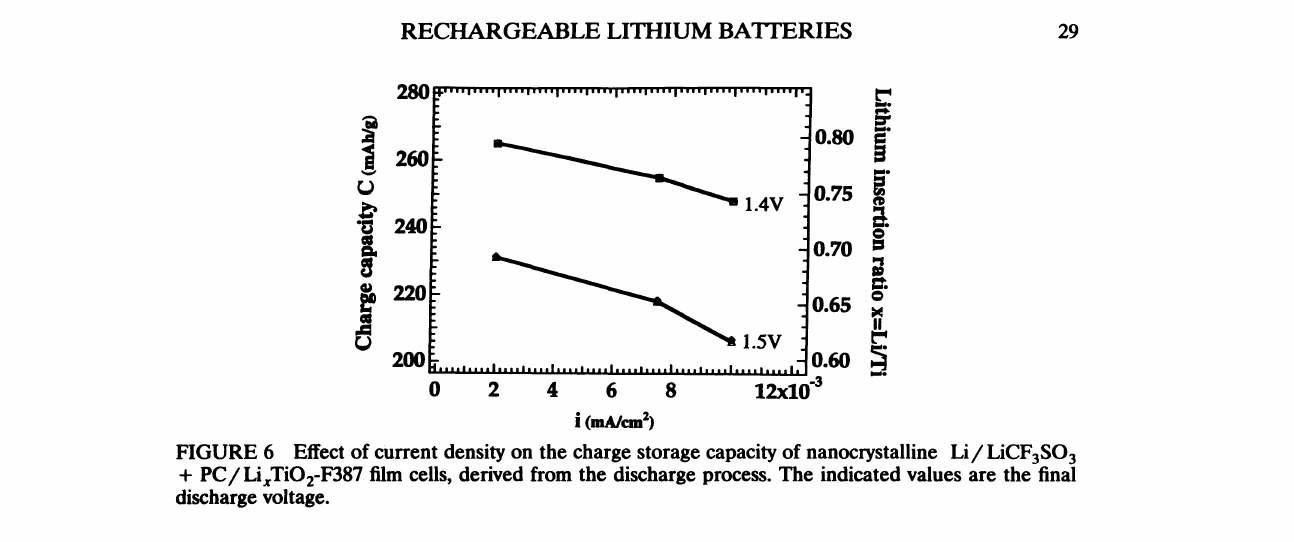
FIGURE 6 Effect of current density on the charge storage capacity of nanocrystalline Li/LiCF3SO + PC/LixTiO2-F387 film cells, derived from the discharge process. The indicated values are the final discharge voltage.